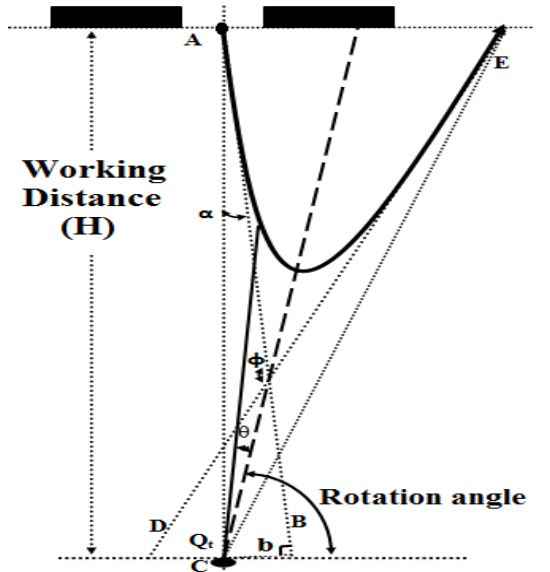
Fig.3: A Schematic diagram for a probing electron trajectory and the shifting of axis.